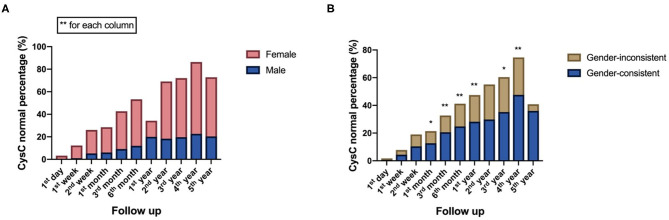
Recipient-related factors of both short-term and long-term impact on postoperative kidney function reflected by CysC value: (A) Comparison of CysC normal percentage between male and female recipients at different time points follow up after surgery. (B) Comparison of CysC normal percentage between gender-consistent and gender-inconsistent groups of donor-recipient at different time points follow up after surgery (*P < 0.05; **P < 0.001).